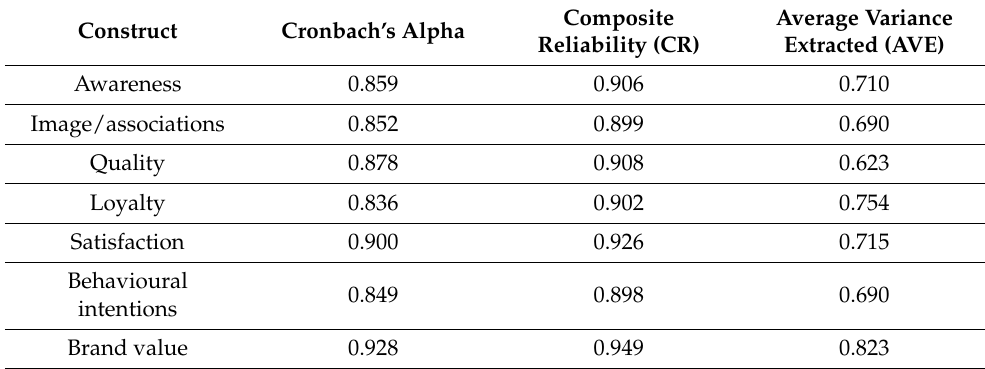
Table 3. Construct reliability (Cronbach’s alpha and CR) and Convergent validity.